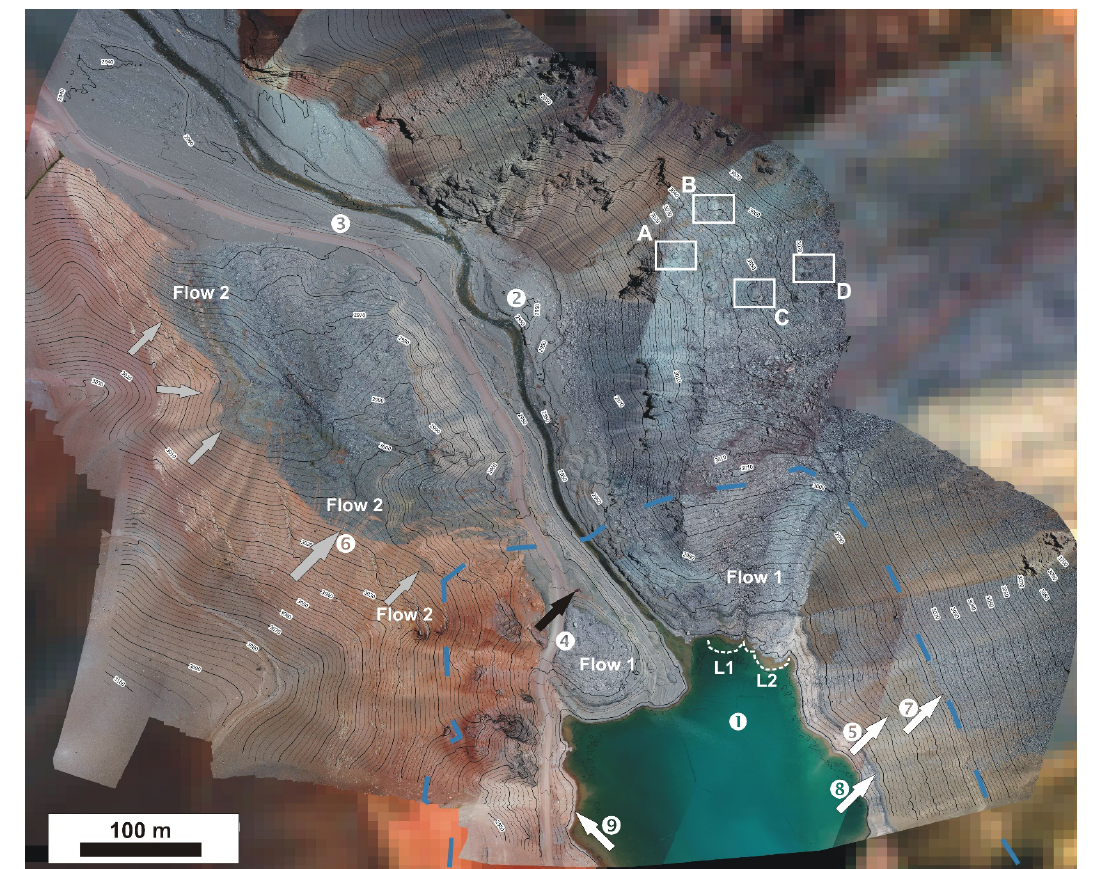
Figure 2. High-resolution topographic survey (6.94 cm GSD) processed with Pix4D to analyse the altimetric relationships of different elements related to the natural dam collapse. (A–D) Rectangles indicating higher resolution captions details of permafrost boulders relicts (see below) White arrows indicate the position of the highest intermediate and the water level mark developed over 15 years after the flood draining event. The additional 8 m-level drop is due to road-building actions. Black arrow points to a known reference (truck is 5.5 m long). Grey arrows indicate different lobes of Flow 2, the largest one shows the highest topographic reach of Flow 2 deposits. L1 and L2 are Flow 1 lobes that clearly extend into the lake depth. The photomosaic made by 340 drone images is draped over the image showing the largest attained area of the Erizos Lake, marked by the hatched blue line. Encircled numbers identify the positions of features mentioned in Table 1.